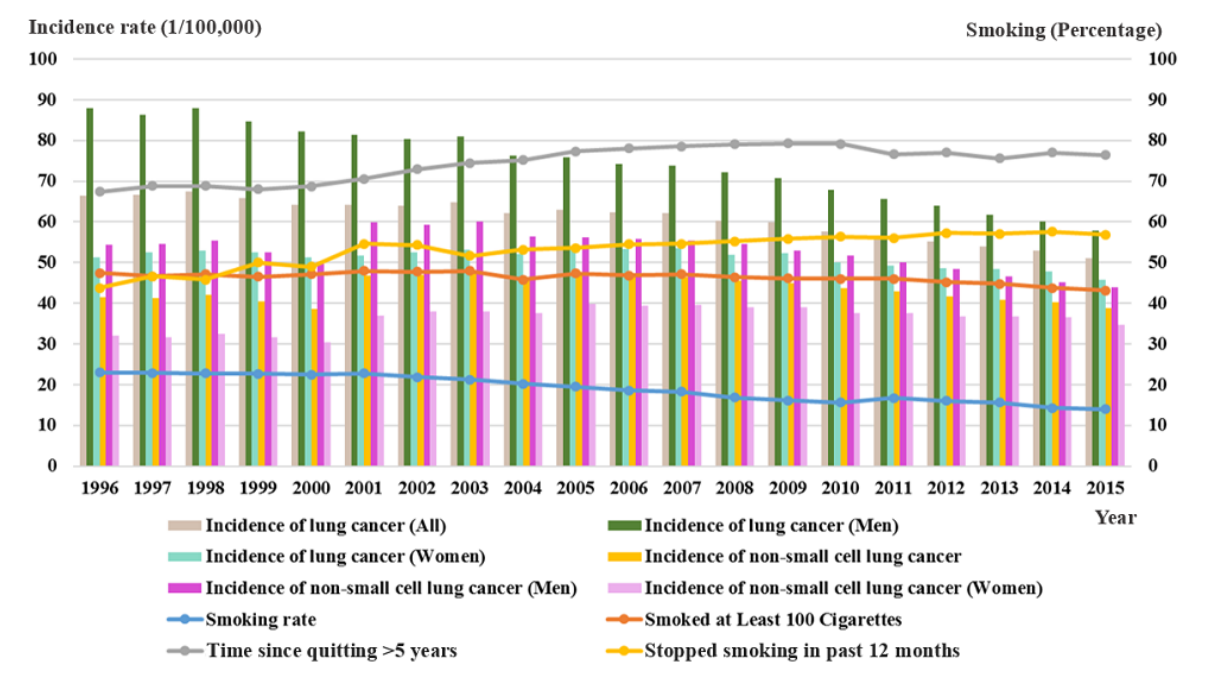
Figure 6. Relationship between smoking and lung cancer incidence, 1996-2015.